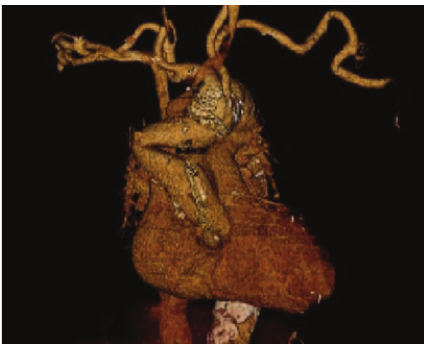
Figure 1: Chest 3-dimensional computed tomography. Computed tomography revealed that the replaced duct was severely bent in the ascending aorta.